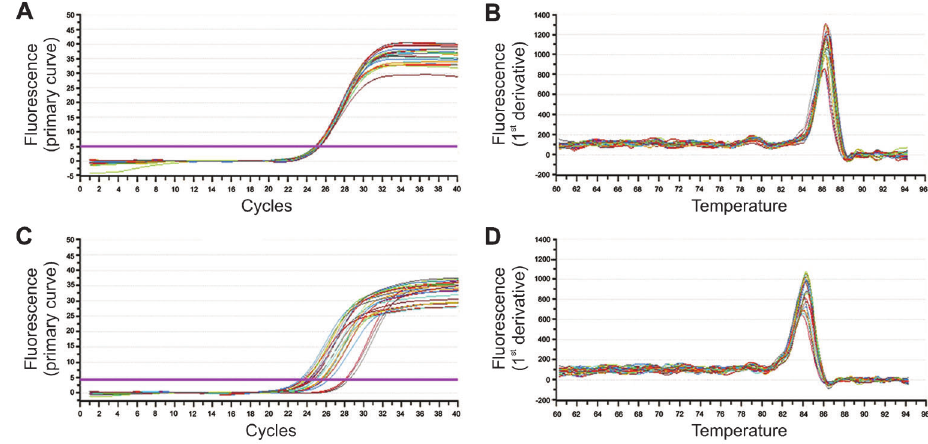
Figure 4. Amplification and dissolution curves for GAPDH and CYP11B2. A , GAPDH amplification curve; B , GAPDH melting curve; C , CYP11B2 amplification curve; D , CYP11B2 melting curve.